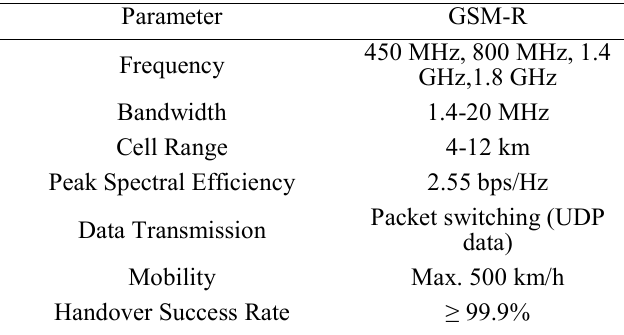
Table 2. Performance of LTE-R system [6] [14]